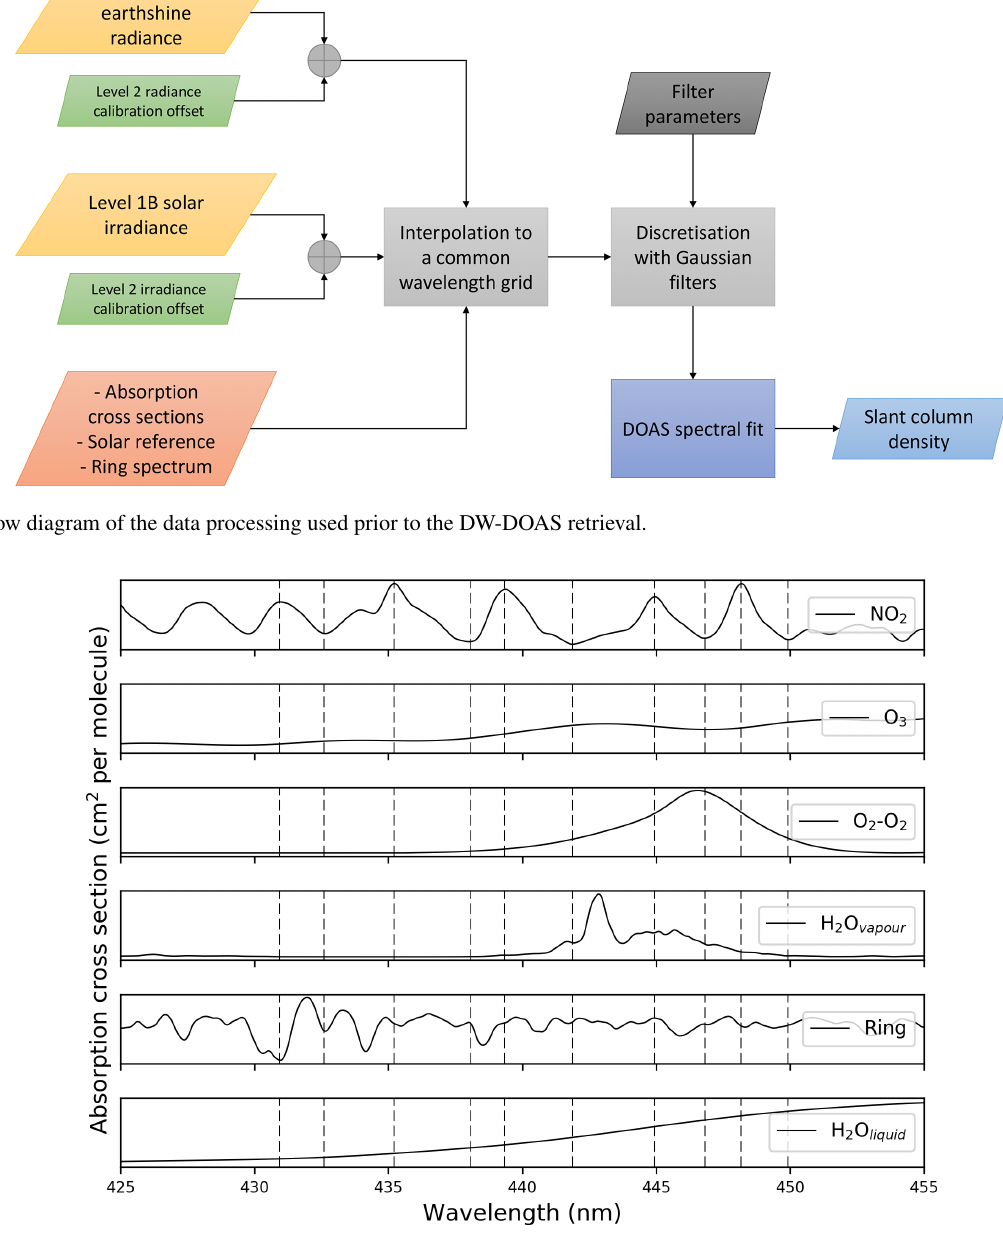
Figure 2. Absorption cross sections of relevant species (solid lines) and position of selected wavelengths (dashed lines) for this